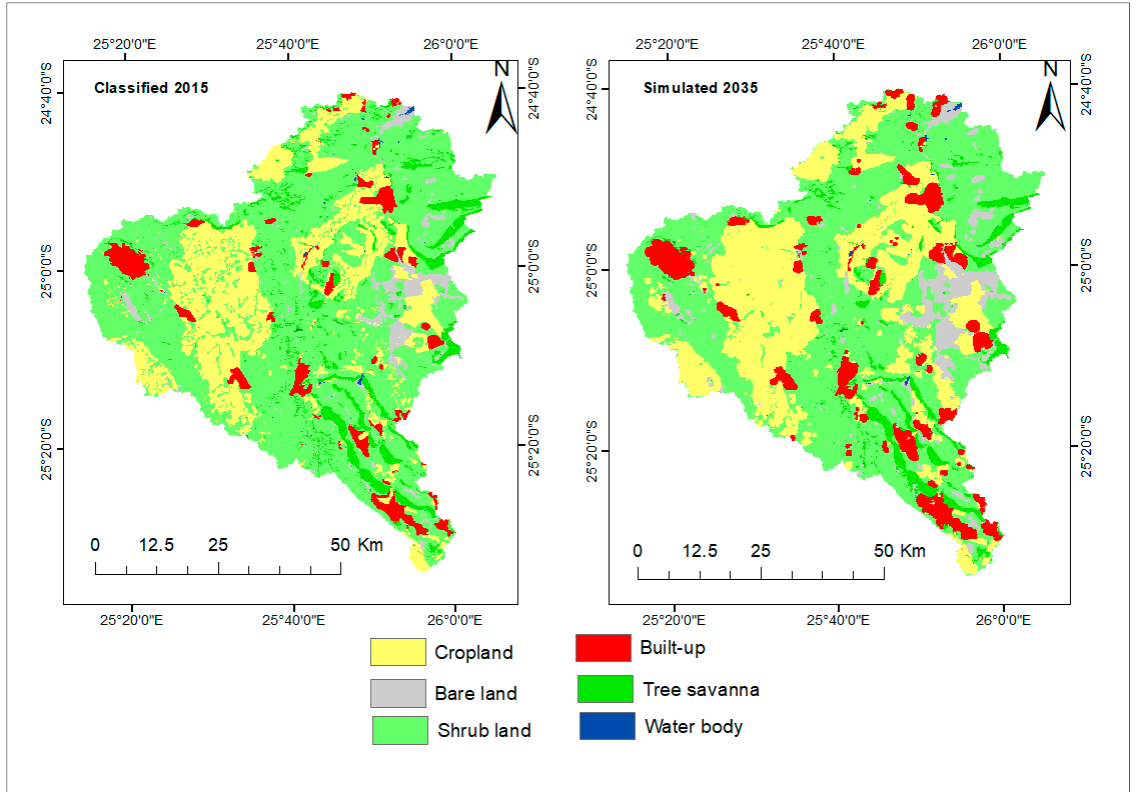
Figure 8. LULC distribution in the Gaborone dam catchment for 2015 (classified) and 2035 (simulated). Table 6. LULC change distribution from 2015–2035.